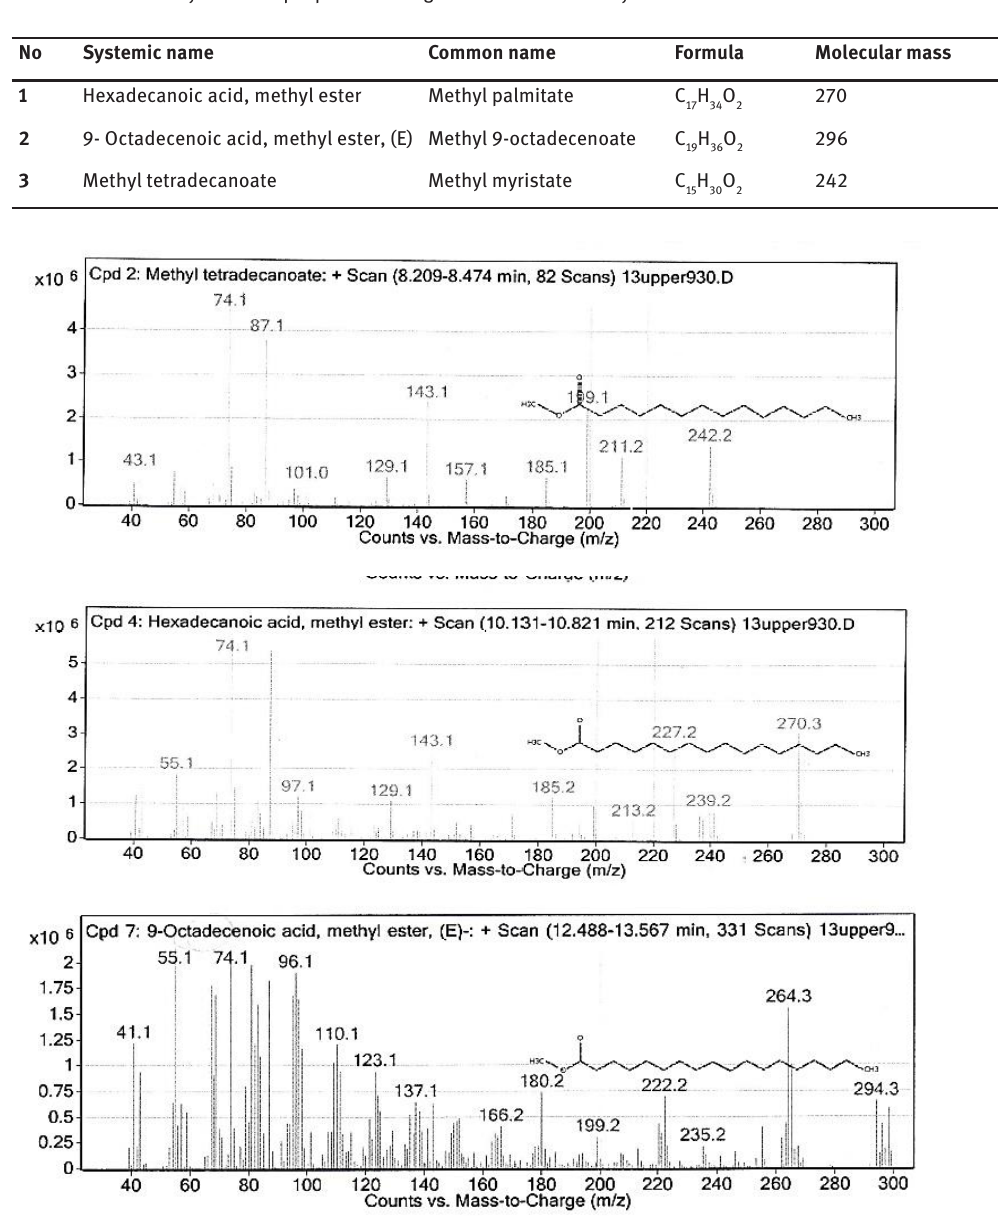
Figure 9: Mas spectrum of selected components after transesterification using calcined